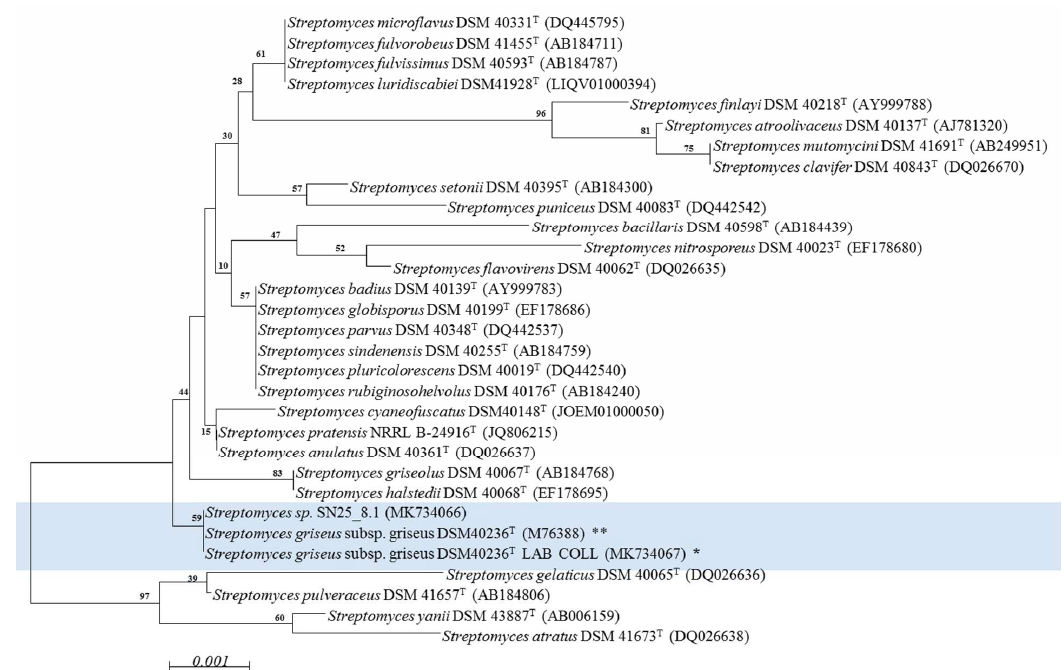
Figure 1. Phylogenetic characterization of the Streptomyces strains using a neighbor joining model. Light blue: experimentally compared Streptomyces strains. Bootstrap = 1000; Bootstrap values are shown on the branch, where 100 is maximum; T : type strain; NCBI access number is within parenthesis. * Streptomyces griseus subsp. griseus DSM 40236 T LAB COLL: Sequence experimentally obtained from fresh cultures and deposited in NCBI (MK734067). ** Streptomyces griseus subsp. griseus DSM 40236 T : Sequence retrieved from NCBI (M76388). The evolutionary distances were computed using the Jukes-Cantor method and are in the units of the number of base substitutions per site (scale). The analysis involved 31 nucleotide sequences. All positions containing gaps and missing data were eliminated. There were a total of 1338 positions in the final dataset.